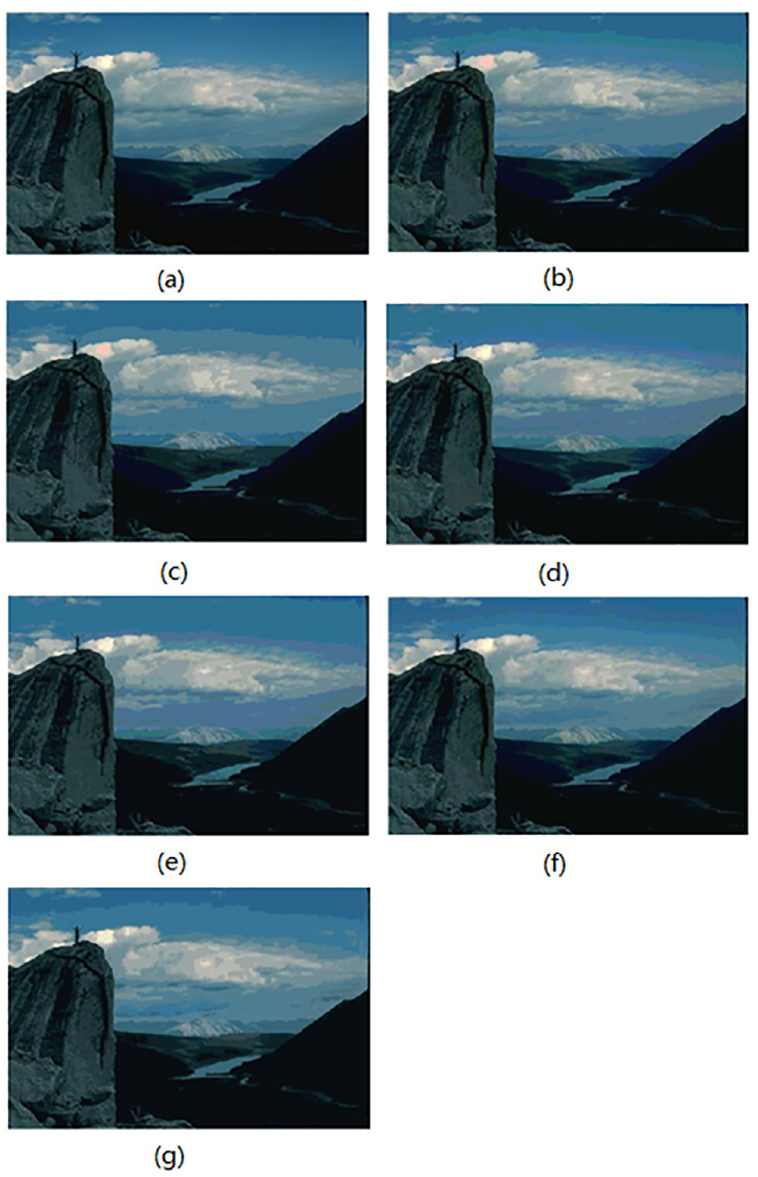
Fig 6. The image Mountain : (a) original image, (b, c) initial segmented result and result after region merging based on the histon, (d, e) initial segmented result and result after region merging based on the roughness index, (f, g) initial segmented result and result after region merging based on AHHT